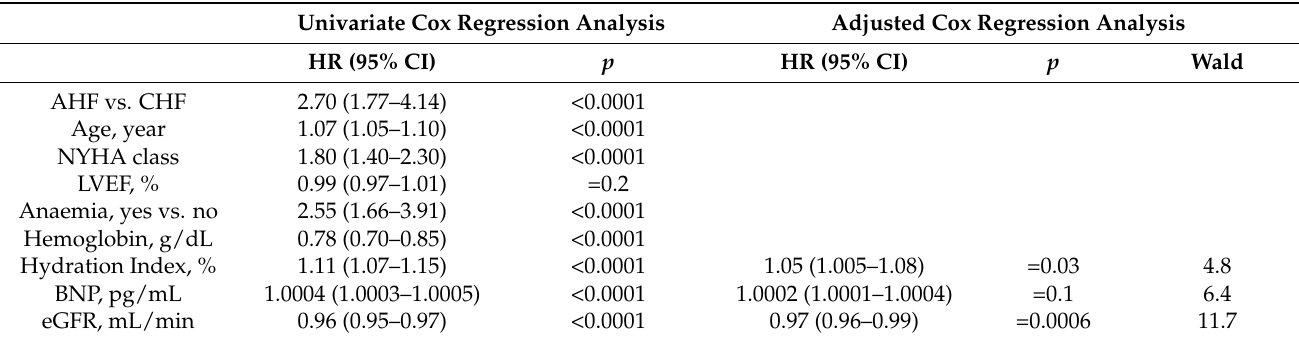
Table 3. Univariate and multivariate Cox proportional hazards survival analyses.